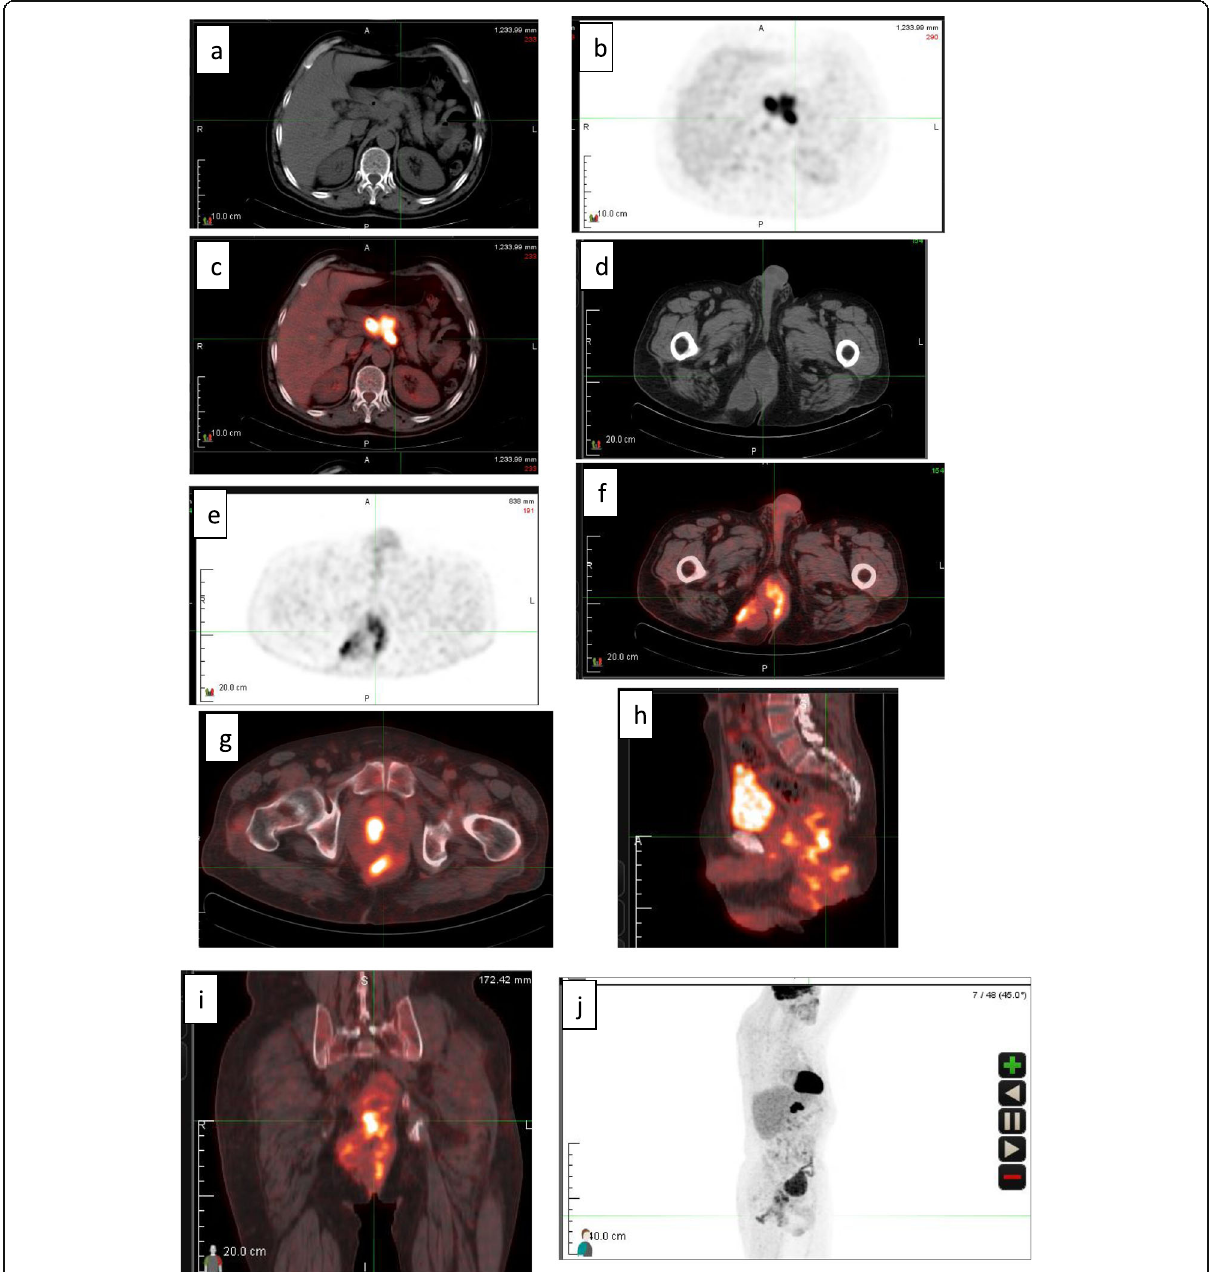
Fig. 5 A 53-year-old male patient with NHL- diffuse large B cell type underwent splenectomy and received chemotherapy presented by peri-anal swelling. CT ( a ), PET ( b ), and PET/CT ( c ) revealed FDG- avid peri-pancreatic/caeliac LNs with each other are also seen and measures about (6.2 × 4.8 cm) with SUV 22). CT ( d ), PET ( e ), and PET/CT ( f – i ) show metabolically active pre-coccygeal mixed cystic and solid soft tissue mass with few calcific foci seen inside, infiltrating the posterior and lateral walls of the rectum and anal canal encroaching upon the posterior aspect of the colon, and the prostate and extends to the overlying skin and subcutaneous tissue of the gluteal region and measures about 8.7 × 7.5 × 16 cm in dimensions with inhomogeneous FDG tracer fixation of its solid components and SUVmax 10.6. MIP PET image ( j ) confirms the findings. US- guided core biopsy of pre-coccygeal mass on revealed anaplastic adenocarcinoma and patient received